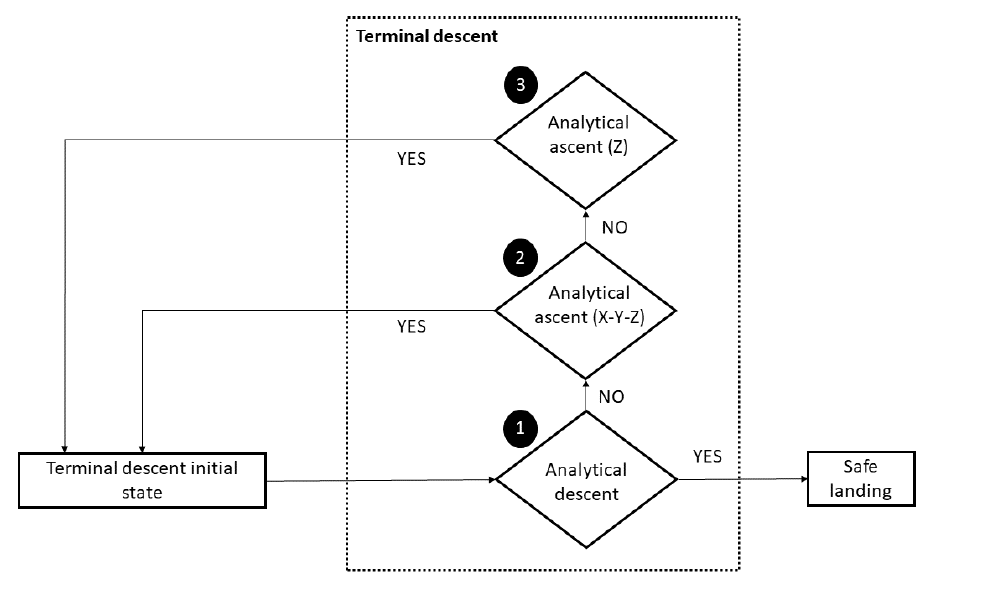
Figure 11. Terminal descent flow